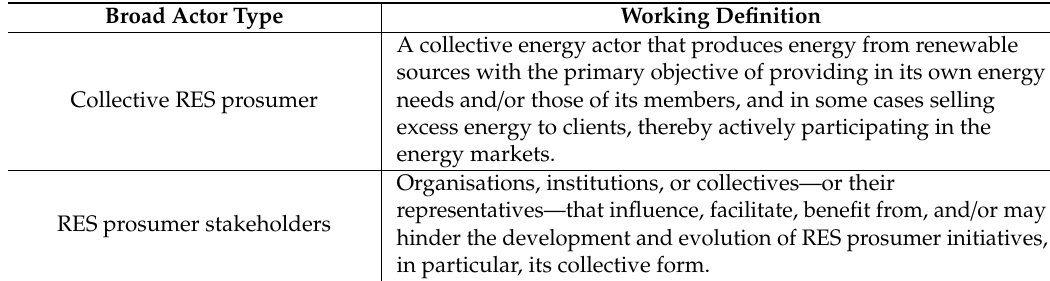
Table 1. Working definitions of collective renewable energy sources (RES) prosumers and RES prosumer stakeholders. Source: [23] (pp. 24–25).